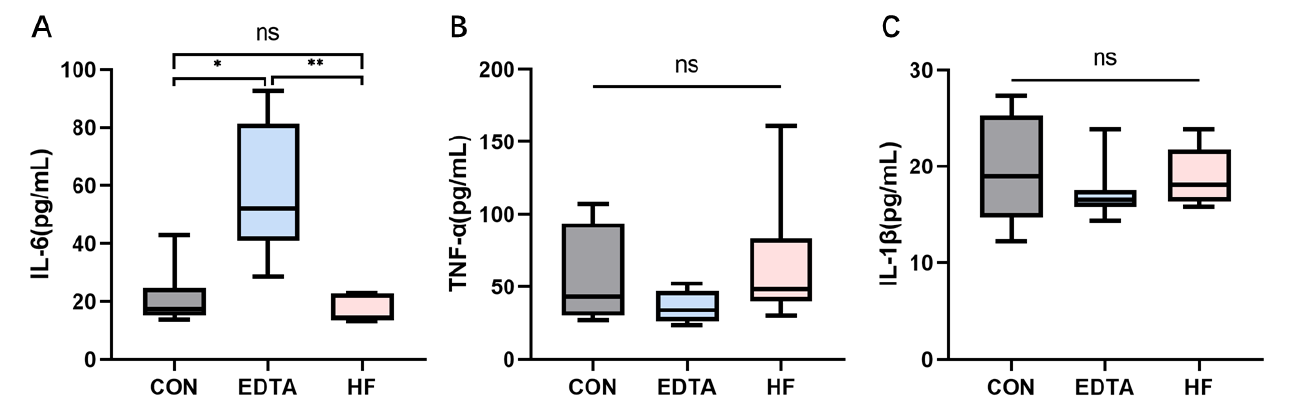
Figure 3. Levels of IL-6, TNF-α and IL-1β in the serum of each group detected by ELISA. ( A ) Level of IL-6 in the serum of each group. ( B ) Level of TNF-α in the serum of each group. ( C ) Level of IL- 1β in the serum of each group. CON: control group, EDTA: experimental group, HF: recovery group. Statistically significant differences are indicated by * p < 0.05, ** p < 0.01.